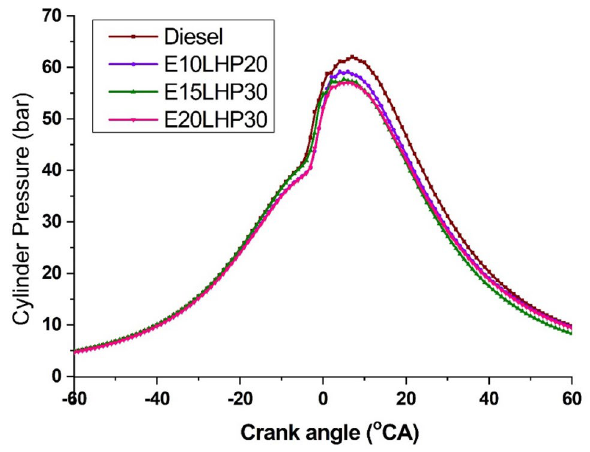
Figure 9. Impact of in-cylinder pressure on LHP and ethanol blends.